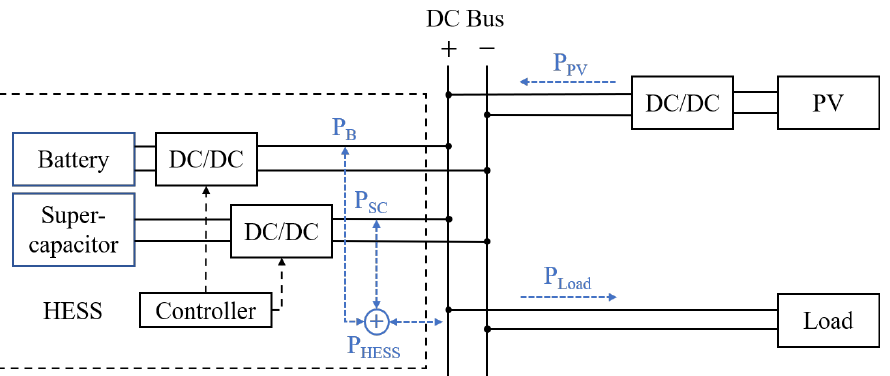
Figure 1. Selected system topology: DC microgrid with a parallel, fully-active hybrid energy storage system